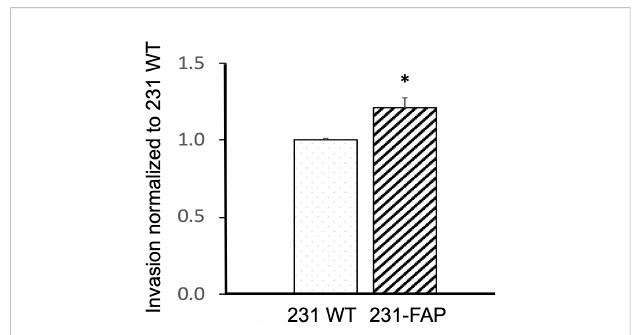
FIGURE 5 Invasion normalized to 231 WT cells in response to 10% FBS for 231 WT and 231-FAP cells (n = 3) over a 24 h period. Values represent Mean ± SEM. * P ≤